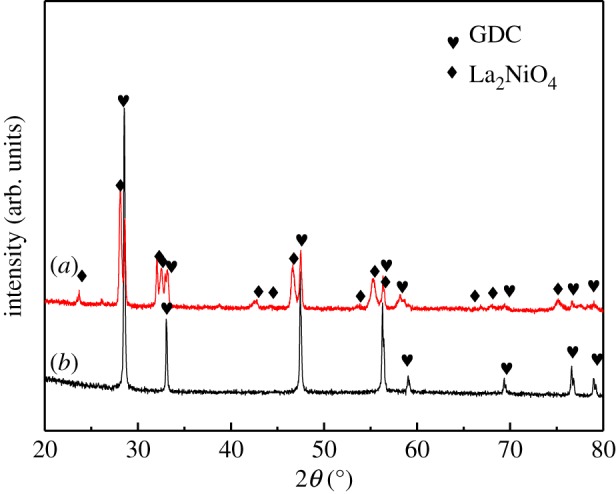
XRD patterns of GDC (b) and La2NiO4 powder mixtures (a) after heated at 1050°C.